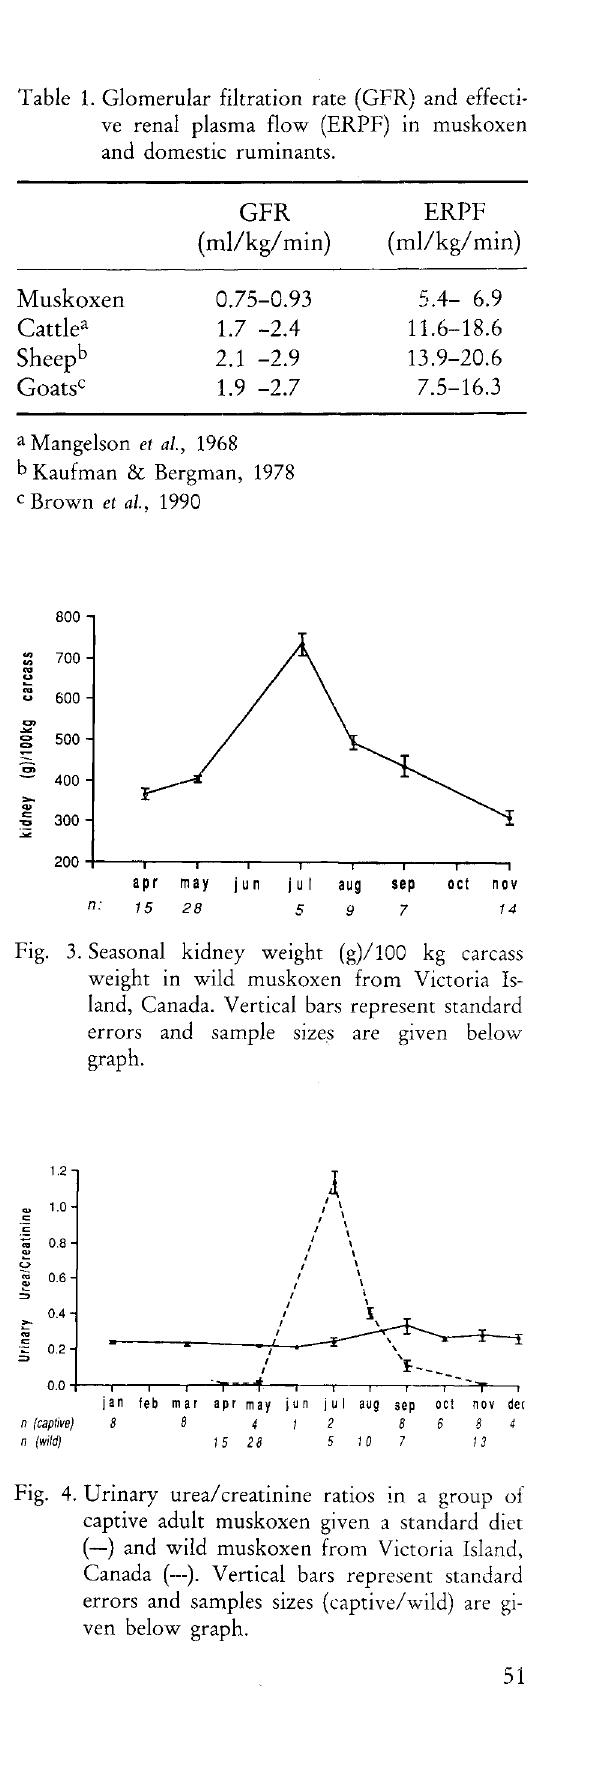
Table 1. Glomerular filtration rate (GFR) and effecti ve renal plasma flow (ERPF) in muskoxen and domestic ruminants.